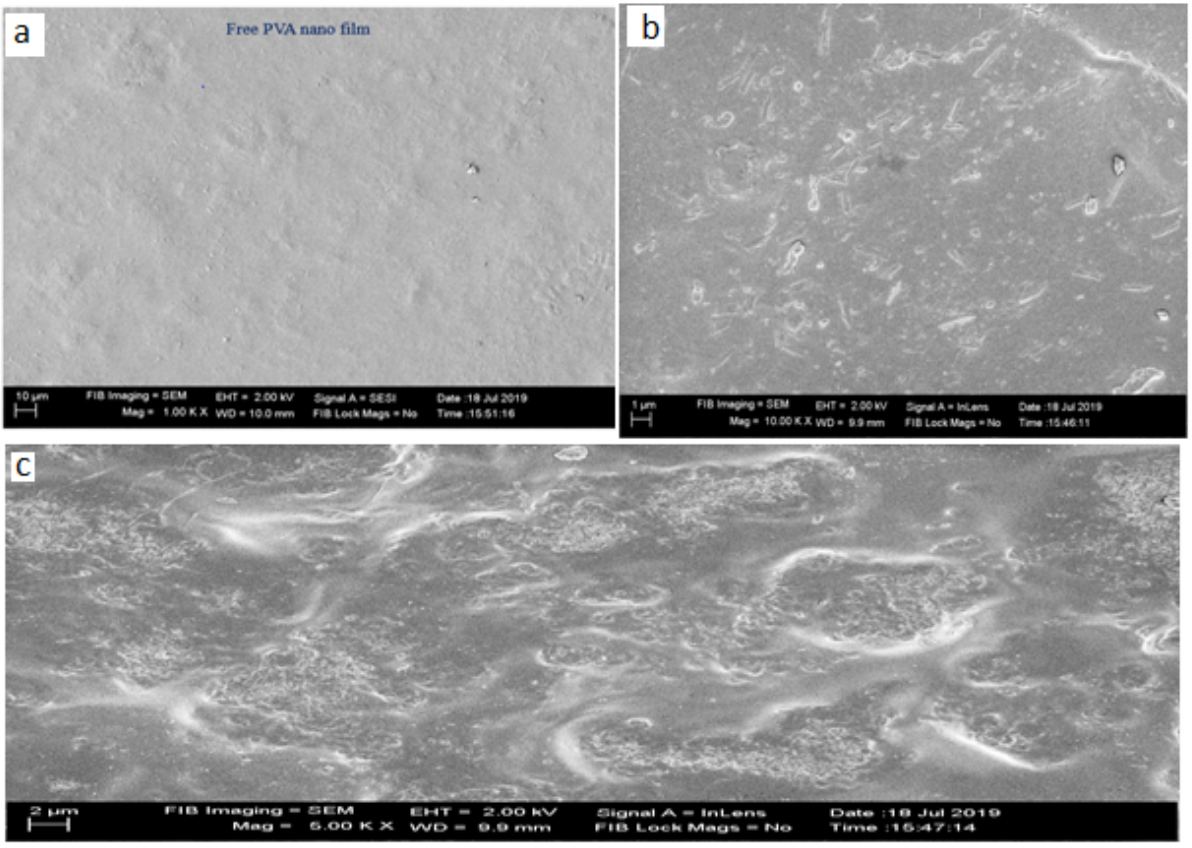
Figure 14: (a-c): SEM images of a) pure casted PVA, b) 5% ZnO/PVA c) 16% ZnO/PVA NC films synthesized at pH 10.5